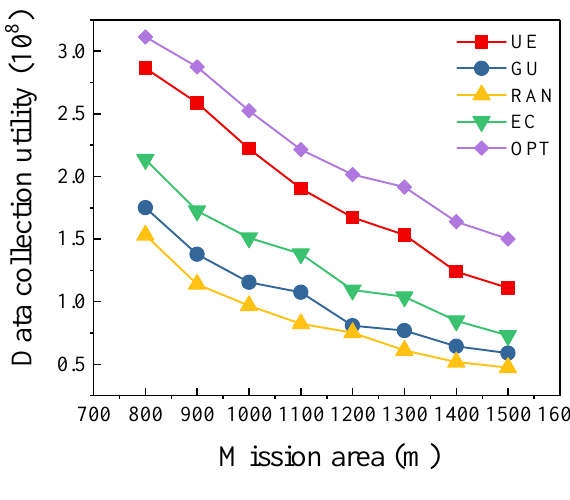
Figure 6. Different Mission Area Sizes.